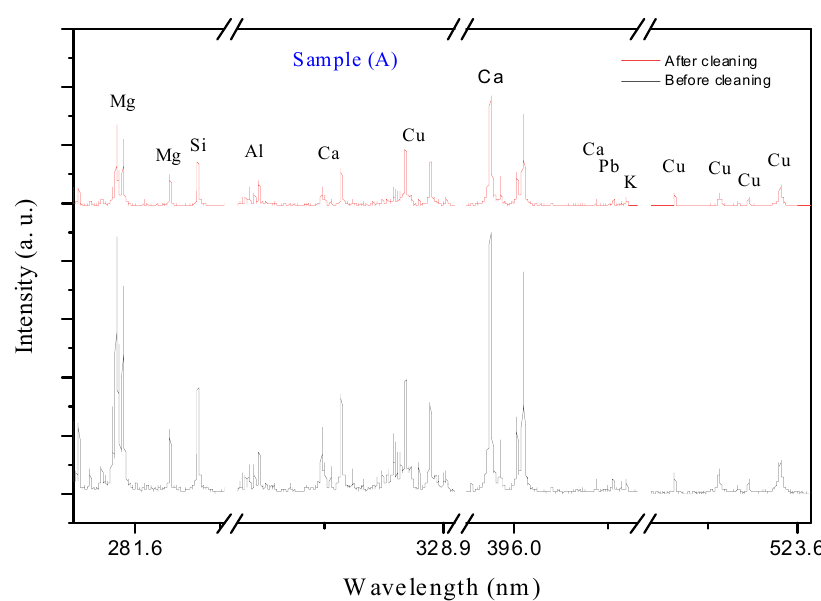
Figure 5. The LIBS spectra of the corroded coin sample (A) before and after cleaning.